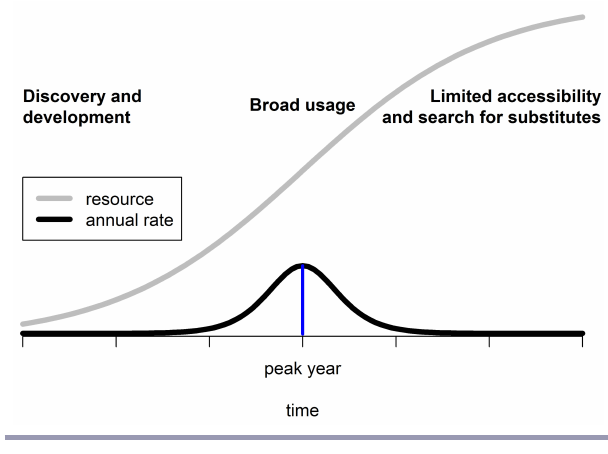
Fig. 1 . Conceptually, the peak-rate year of resource use is the point in time with the maximum appropriation rate (blue